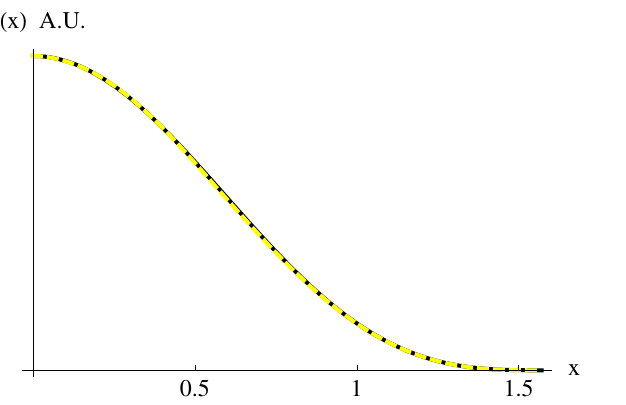
Figure 40 . Zero-mode of a Boson Star compared with the \pro(cid:12)le increment" of the scalar (cid:12)eld along the Boson Stars branch. The plots are rescaled in order to overlap.